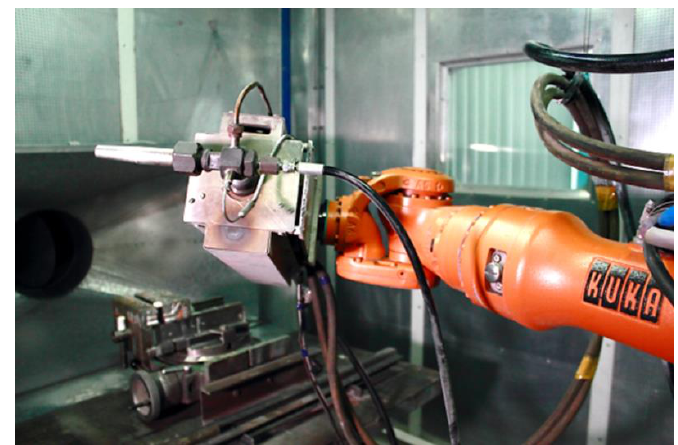
Fig. 1. Cold spray unit on industrial robot.